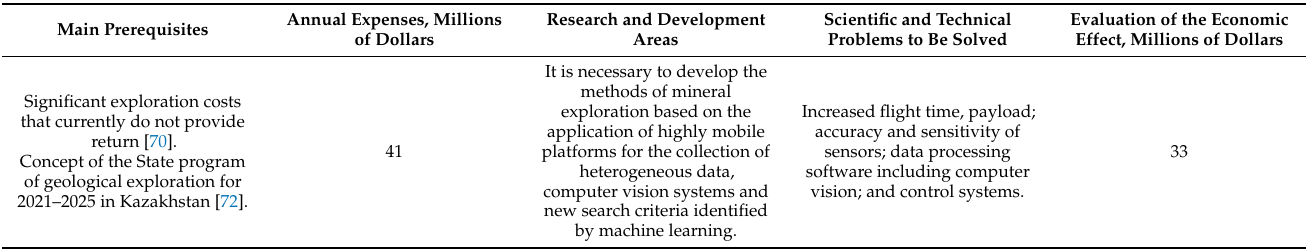
Table A4. IUAVT use for the task of minerals exploration.